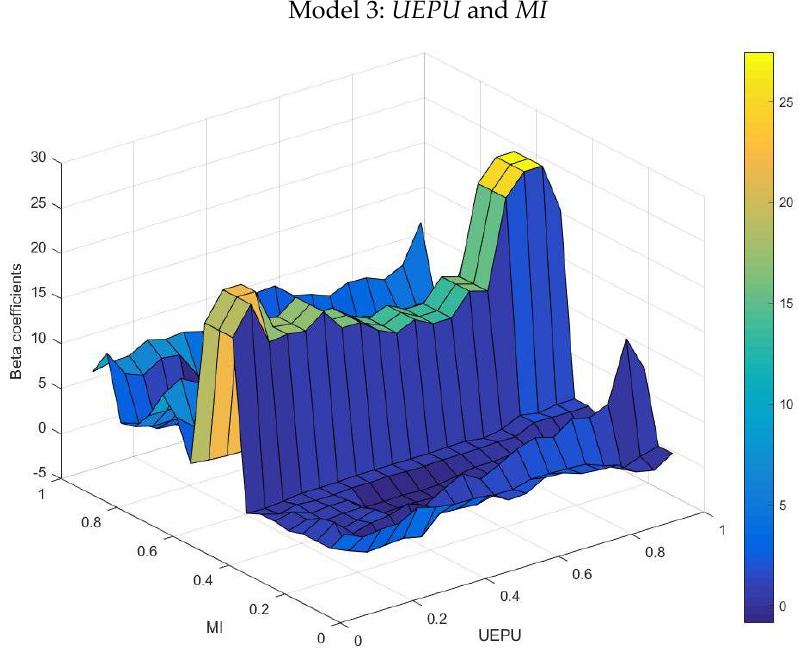
Figure 8. US economic policy uncertainty ( UEPU ) and mineral import ( MI ). Notes: The z -axis exhibits the slope coefficients against the quantiles of MI ( θ ) on the y -axis and the quantiles of UEPU ( τ ) on the x -axis. The yellow and green colors represent the strongly positive slope coefficients, while the light blue colors display the moderately positive slope coefficients. Besides, the dark blue color reveals the trivially negative slope coefficients.